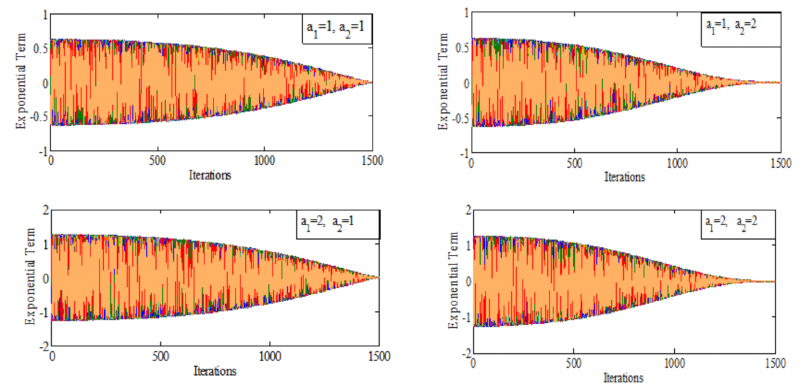
Figure 3. Variation of the exponential term for different combinations of a 1 and a 2